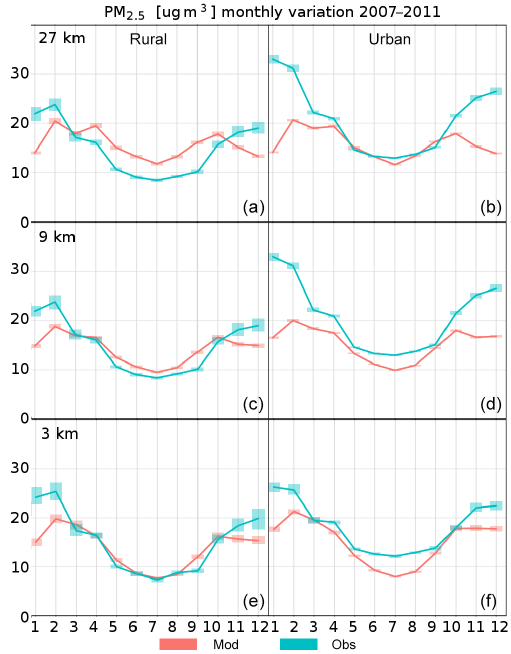
Figure 7. Comparison of monthly PM 2 . 5 concentrations with mea- surements daily in µgm − 3 for rural (a, c, e) and urban background stations (b, d, f) for the three domains (27, 9 and 3km, from top to bottom): model (red) and observation (green).